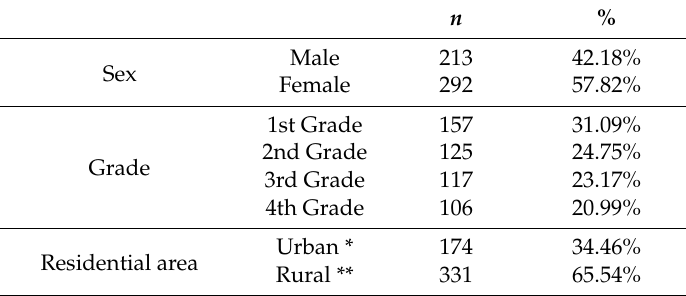
Table 1. Sociodemographic data. Sex, grade, and residential area of the